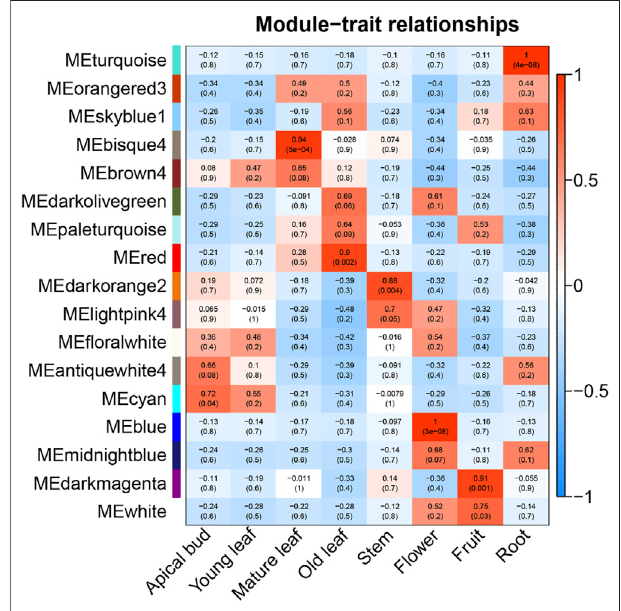
FIGURE 7 | Heat map of module-tissue